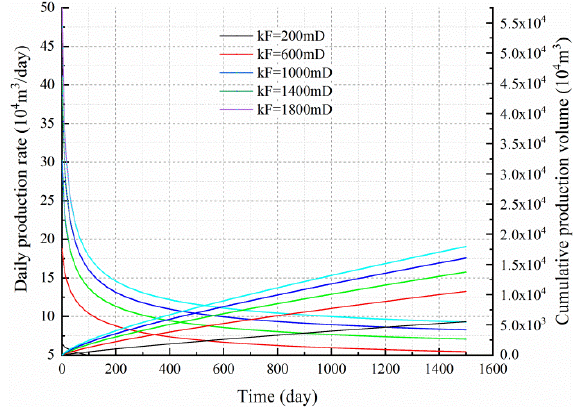
Figure 14. The e ff ect of di ff erent artificial fracture permeability on Figure 14. The effect of different artificial fracture permeability on productivity.